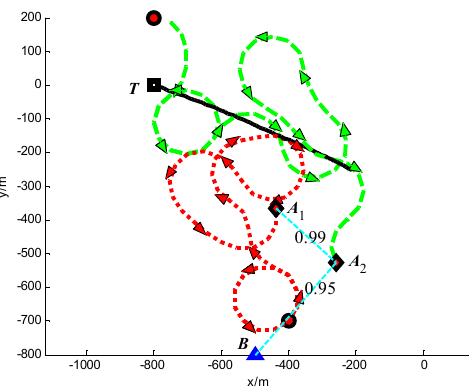
Figure 6. Trajectories of UAVs and target at t = 30 s (Group A in Scenario 1).